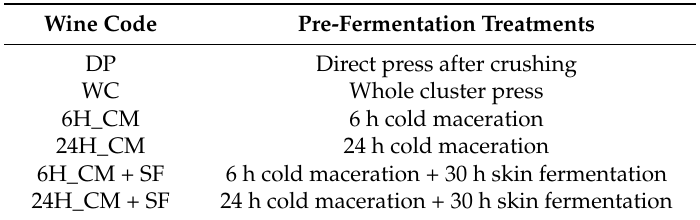
Table 1. Pre-fermentation treatments applied in the study in “Solaris” white